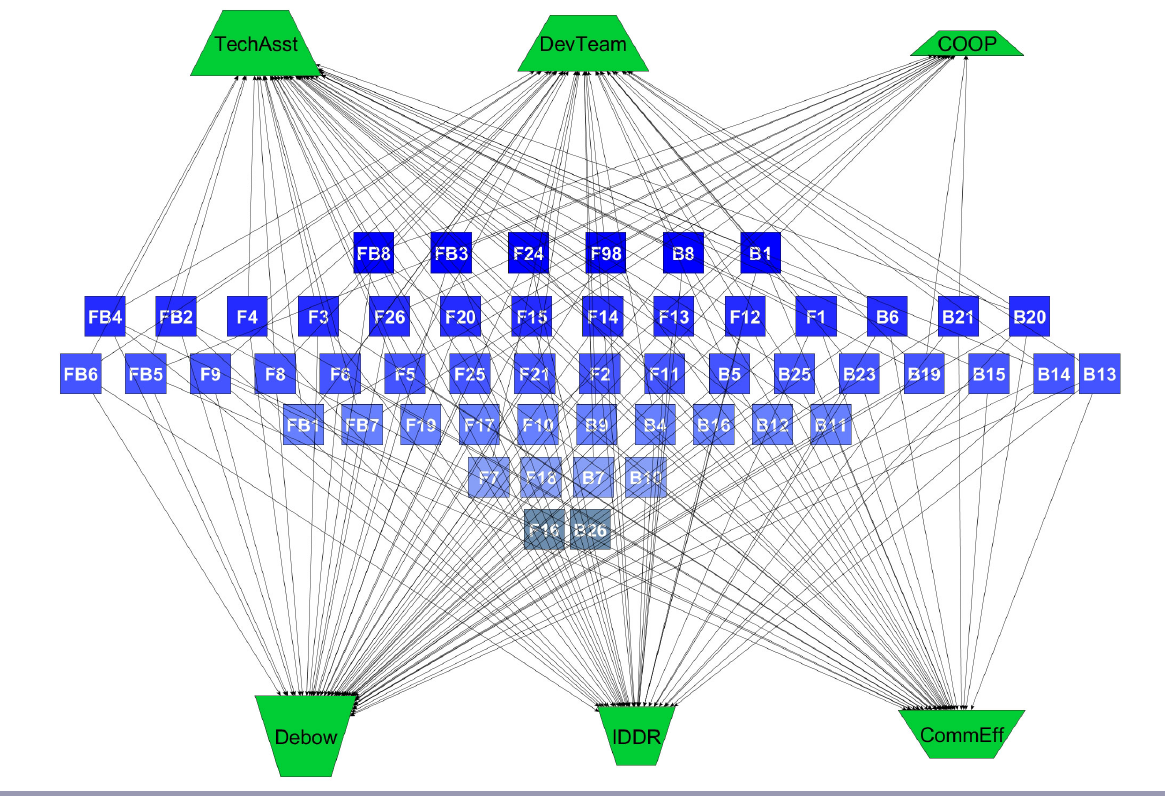
Fig. 8 . Bonding and bridging network. Relative importance of the bonding and bridging interactions are indicated by node size, and relative reliance of the smallholders on bonding and bridging indicated by node